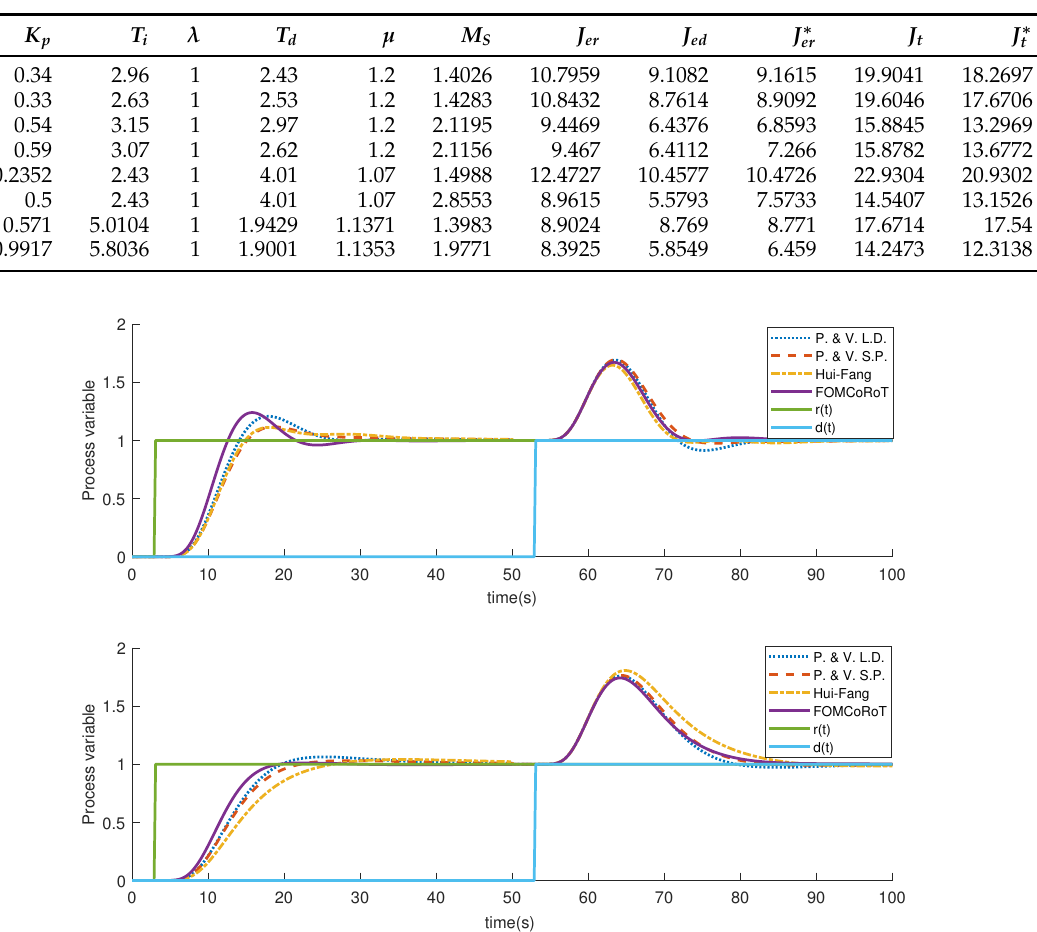
= 2.0 (at the top ) and for M t S